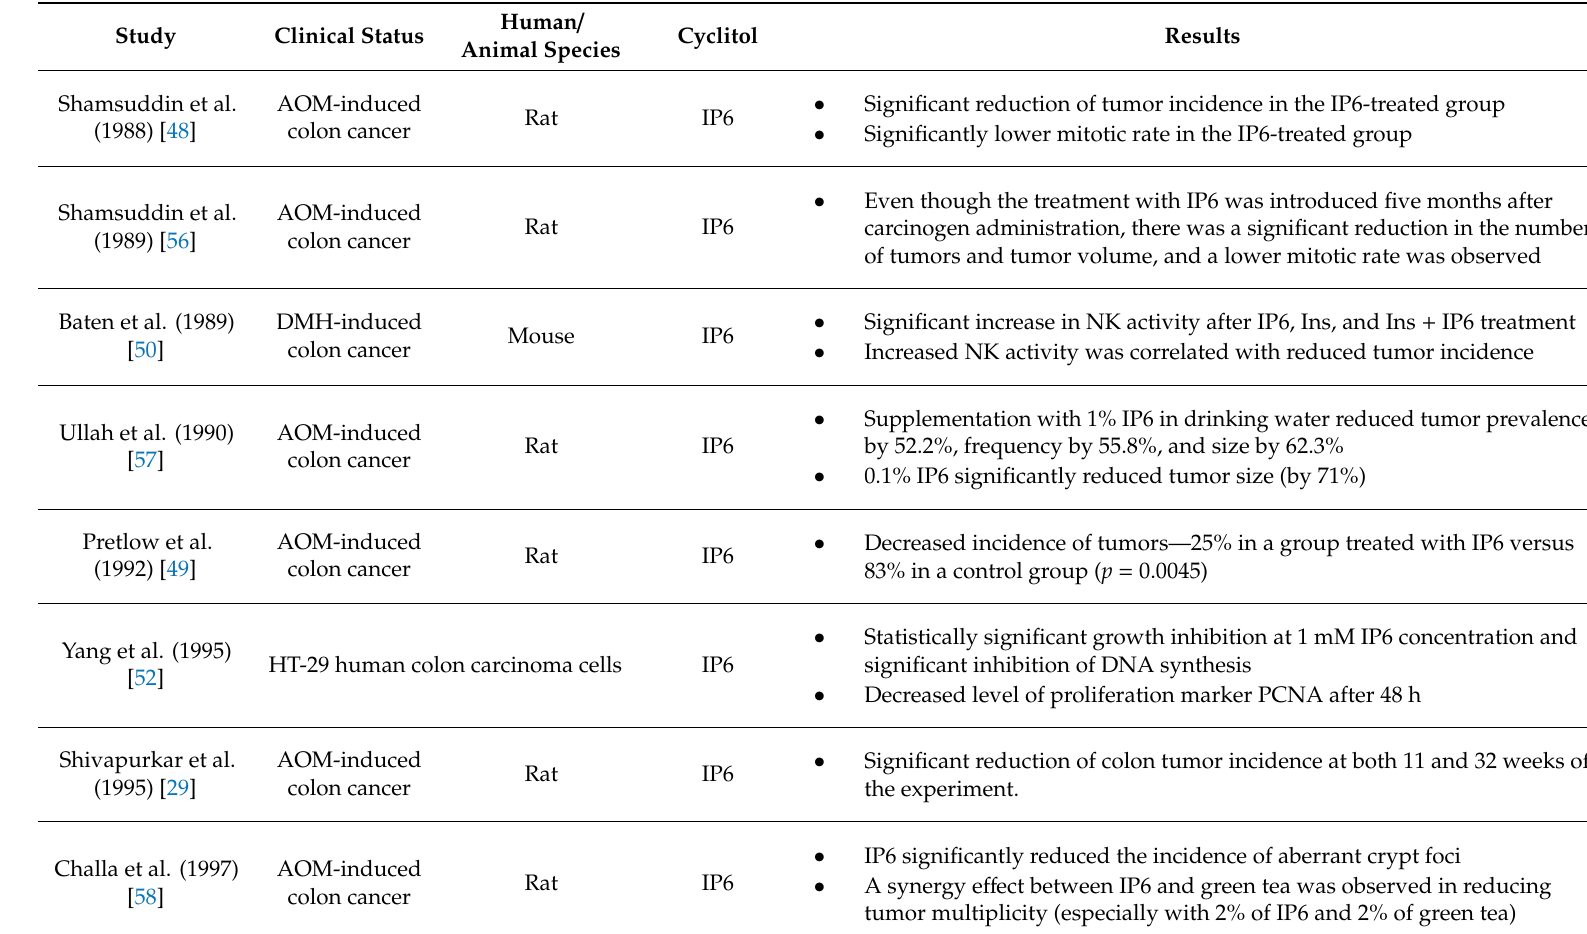
Table 3. Antineoplastic activity of cyclitols in colon